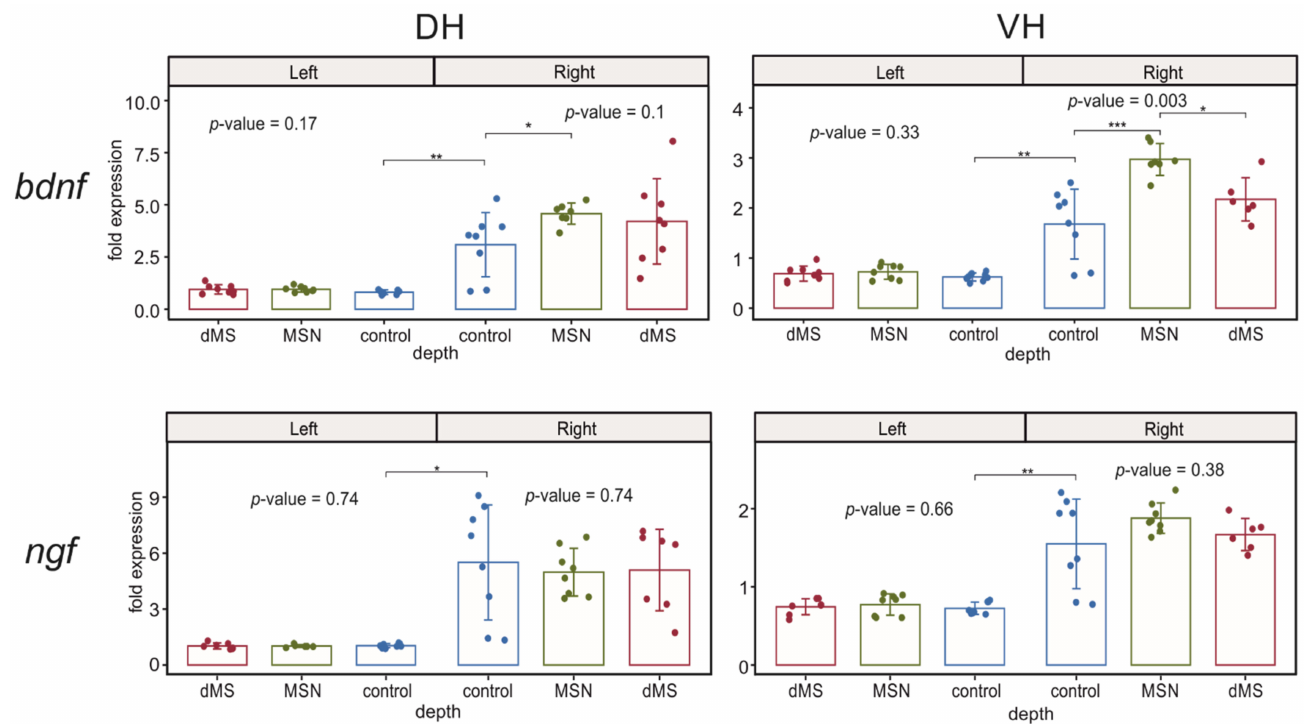
Figure 4. Changes in the expression of neurotrophins after stimulation of the dorsal medium septum and medial septal nucleus in dorsal and ventral parts (DH and VH, respectively) of the left (intact) and right (damaged by implanted electrode) hippocampi. p -values are shown for Kruskal–Wallis test for comparison of three groups in one hemisphere. Interhemispheric comparisons were performed only in the control group using the Mann–Whitney test. For the intergroup comparisons, *, **, and *** mark significant differences at 0.005 ≤ p < 0.025, p < 0.005, and p < 0.0005 (post hoc Dunn test). For interhemispheric comparisons, *, **, and *** mark significant differences at p ≤ 0.05, p < 0.01, and p < 0.001 (Mann–Whitney